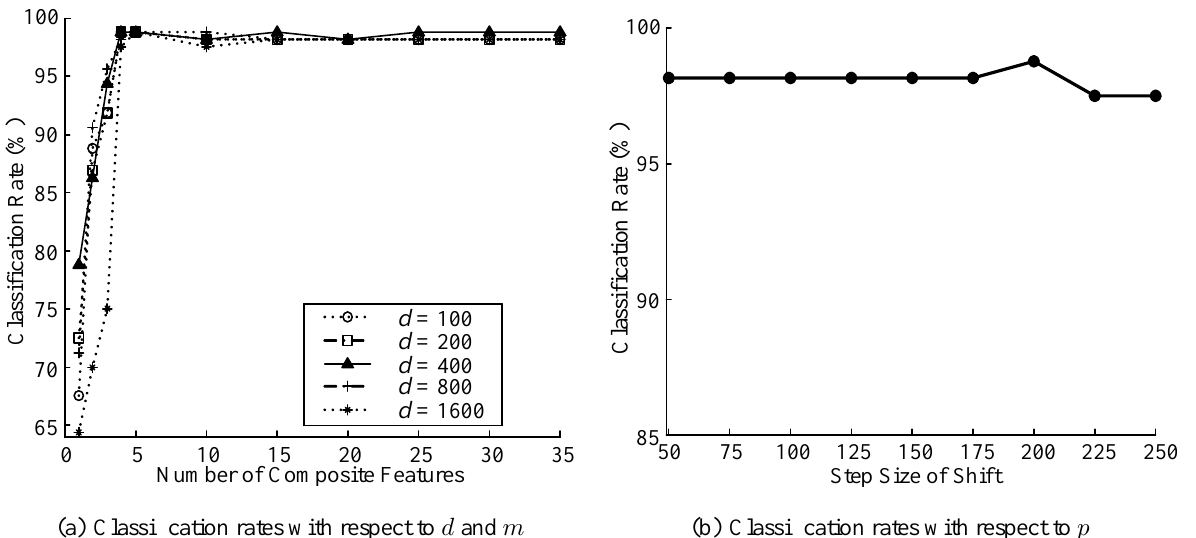
Figure 4. Classification rates for various